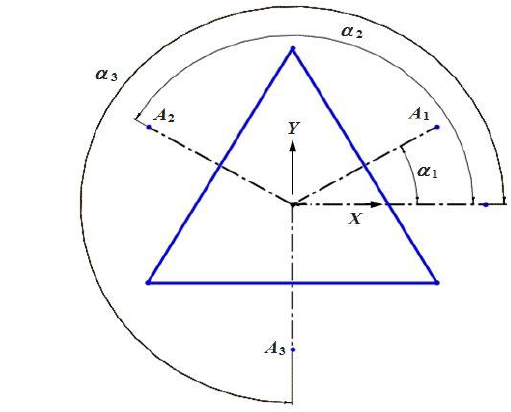
Figure 3. Geometrical parameters of D-PM. Figure 4. Absolute coordinate